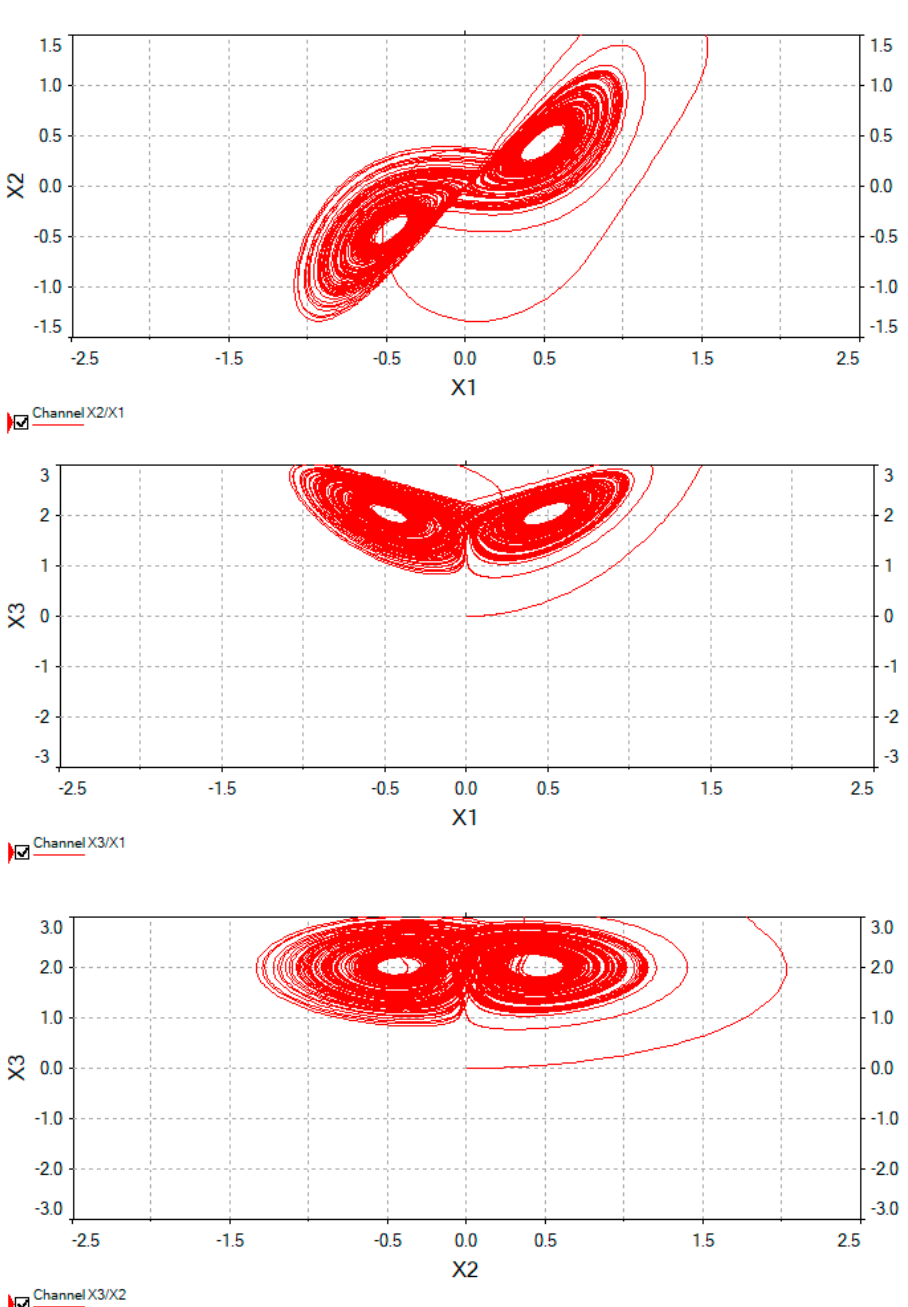
Figure 10. The phase portraits of circuit of the fractional-order chain